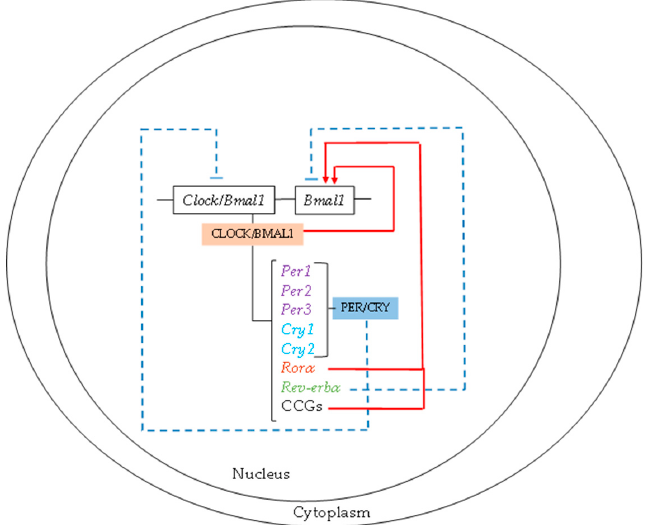
Figure 1. Molecular mechanisms of biological rhythms. The circadian locomotor output cycles kaput / brain and muscle ARNT-like protein 1 (CLOCK / BMAL1) heterodimer is the central clock in all cells and stimulates the transcriptional activity of the period ( Per ) and cryptochrome ( Cry ) genes, whose heterodimer acts as a negative feedback loop of Clock / Bmal1 transcriptional expression. The two feedback loops of Ror α and Rev-erb α expression are regulated by CLOCK / BMAL1.